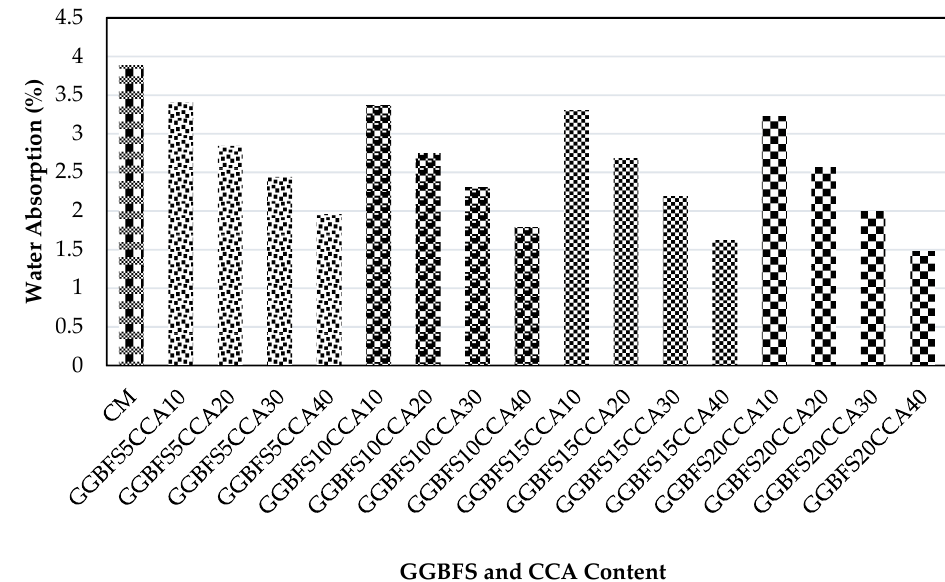
Figure 7. Water absorption of concrete blended with GGBFS along with CCA.